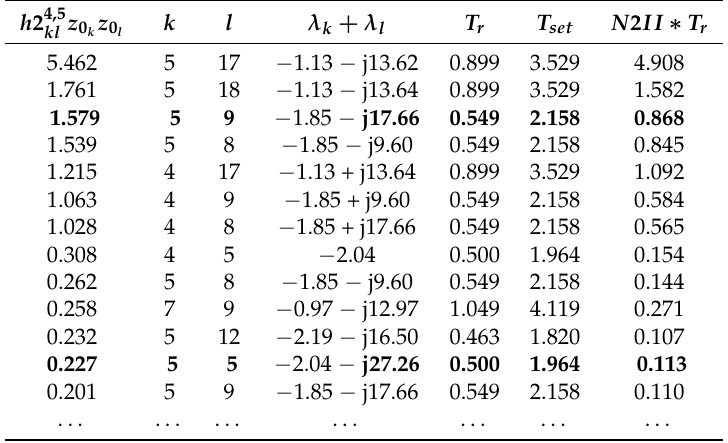
Table 4. NF-35,000—Quantitative Measures of combination Modes for Fundamental Mode